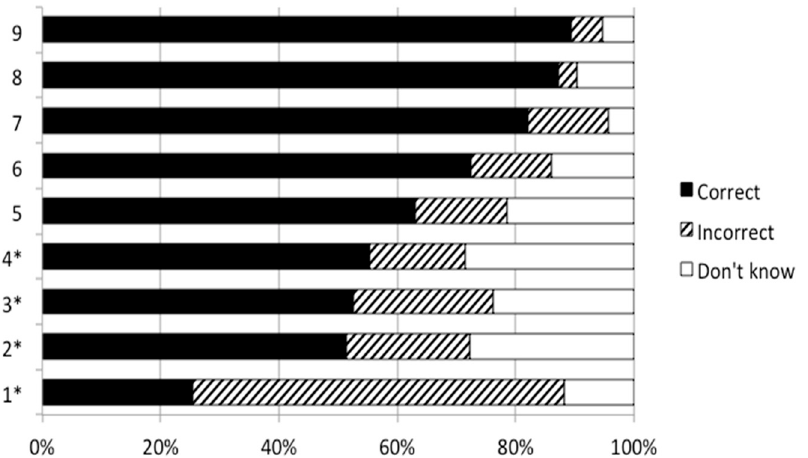
Figure 1. Percentage of correct, incorrect and don’t know answers in the objective protein